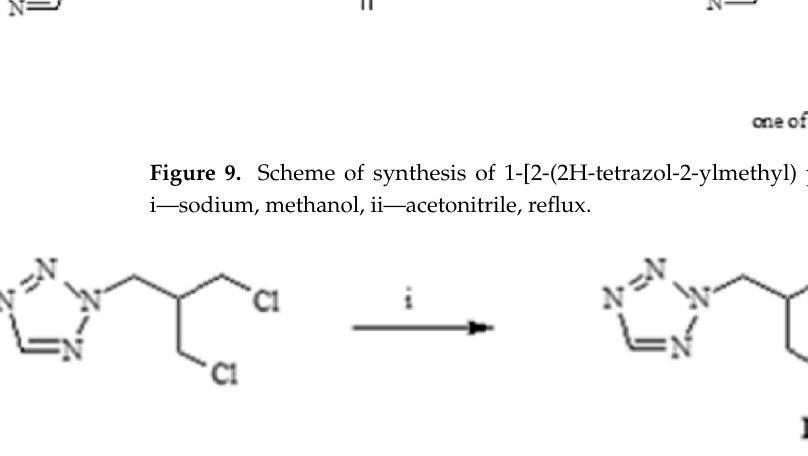
Figure 10. Scheme of synthesis of 1,3-di(tetrazol-2-yl)-2-chloromethylpropane ( 12 ). i—sodium, methanol, 1,2,3-triazole, reflux.